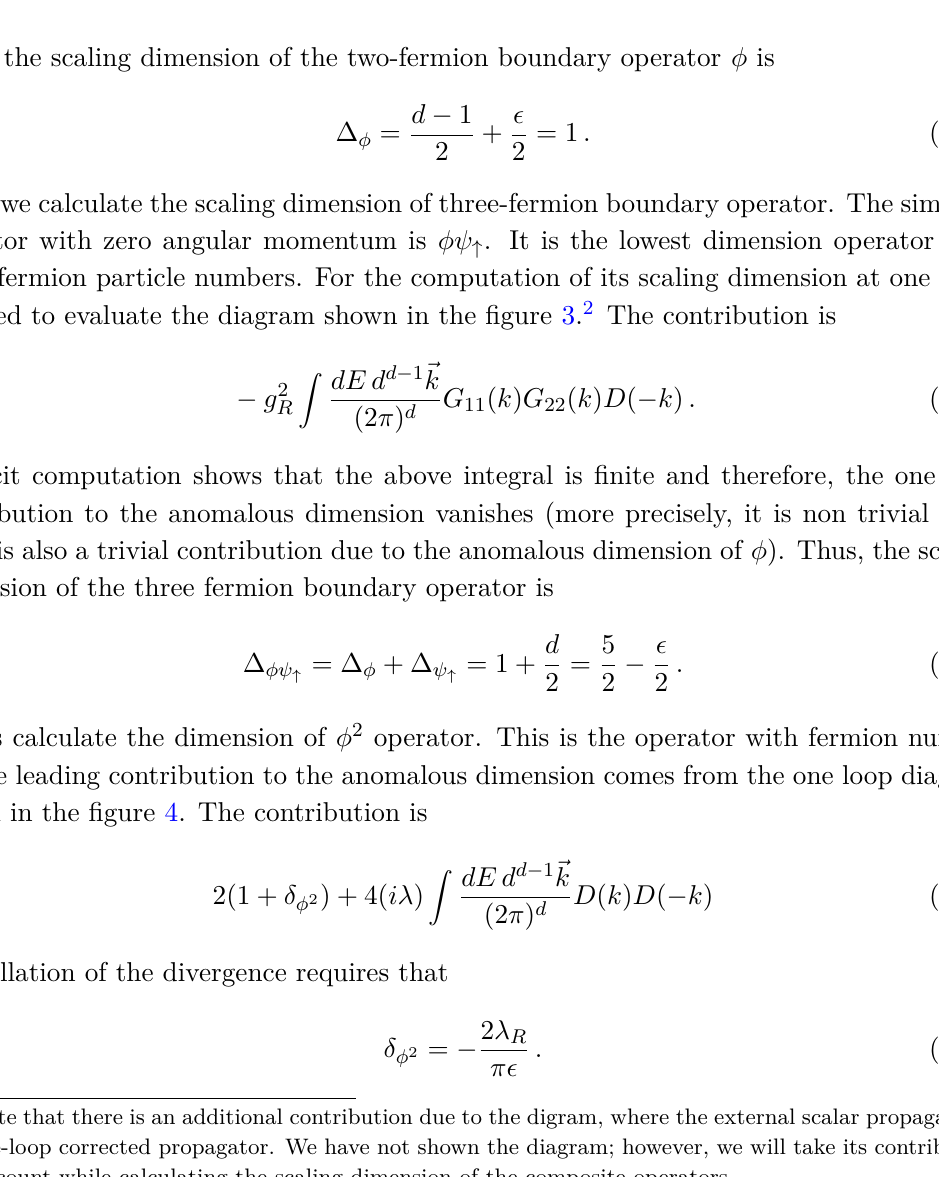
Figure 4 . One loop computation of scaling dimension of four-fermion boundary